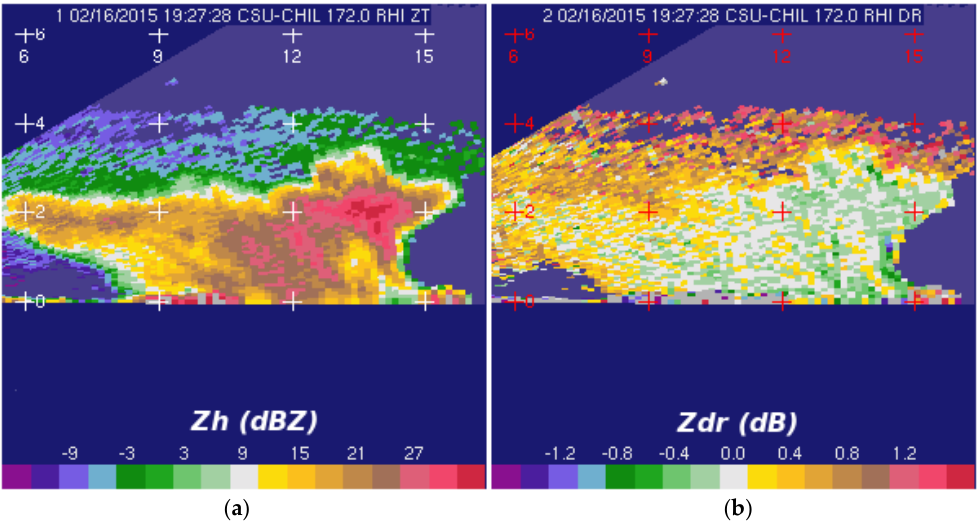
Figure 20. Range-height indicator (RHI) scan through a convective echo near the Easton site (12.92 km range) at 19:27 UTC on 16 February 2015. ( a ) Horizontal reflectivity, Z h , in dBZ; ( b ) Differential reflectivity, Z dr , in dB. Horizontal ranges and heights (AGL) are in km.